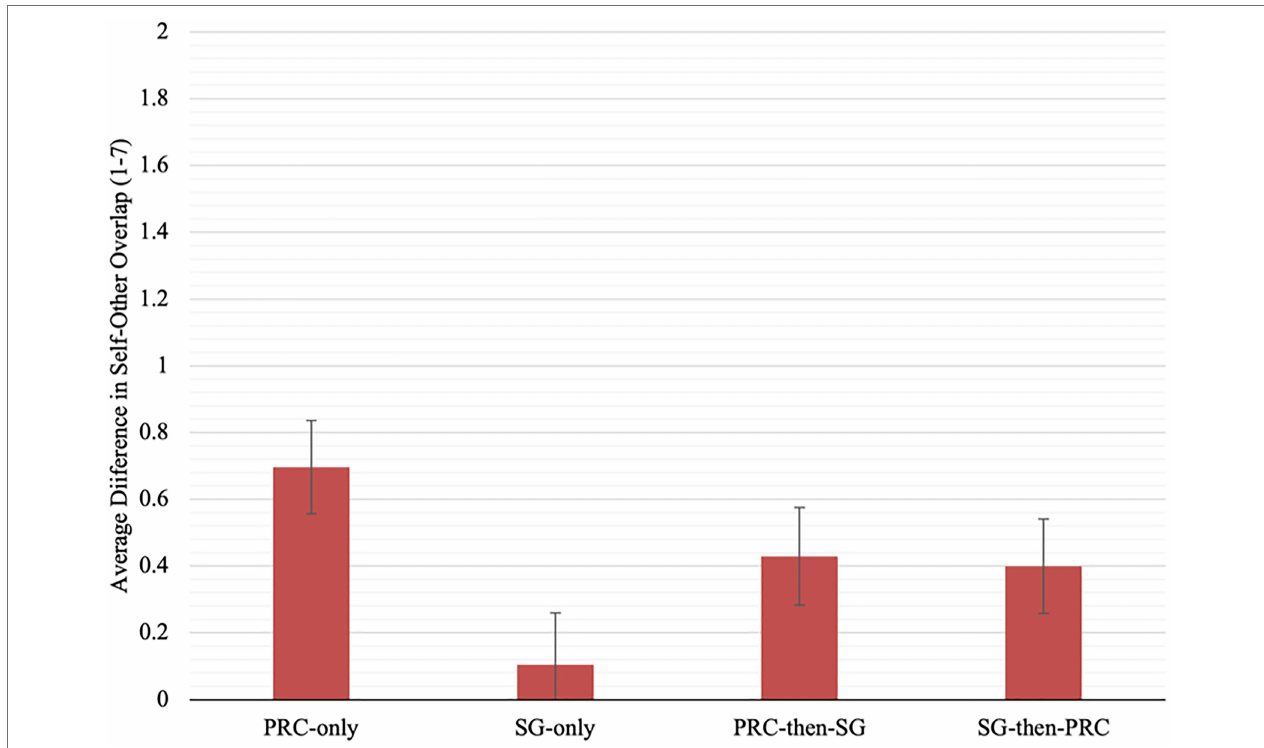
FIGURE 3 | Mean pre-to-post-change in self-other overlap (1–7) for each embodiment condition. Error bars represent standard errors of the